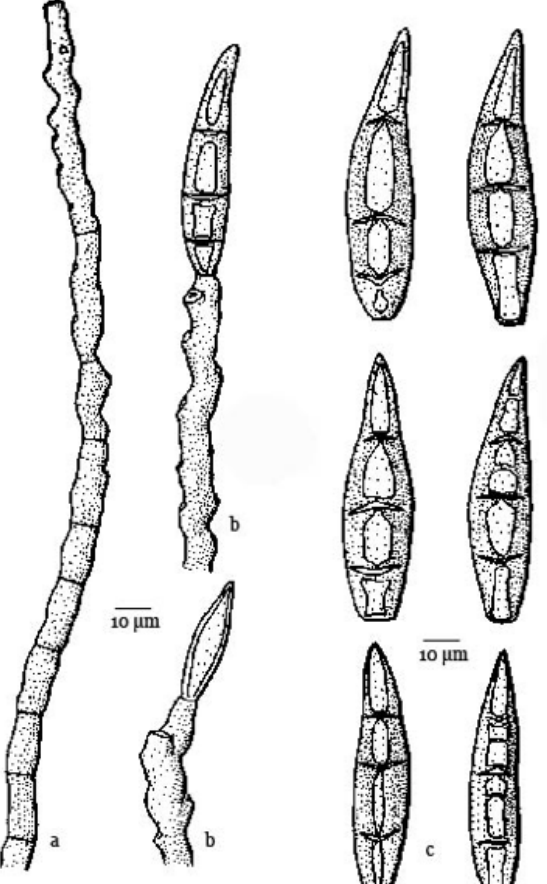
Figure 202. Spiropes guareicola a - Conidiophore; b - Conidiogeneous cells; c -